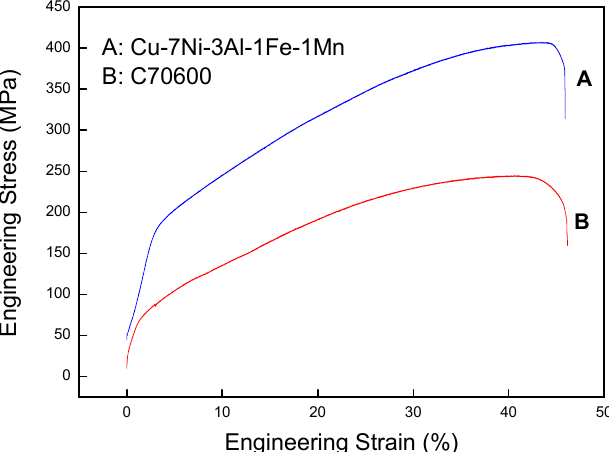
Figure 10. Engineering stress–strain curves at room temperature of the commercial alloy UNS C70600 and Cu-7Ni-3Al-1Fe-1Mn alloy.